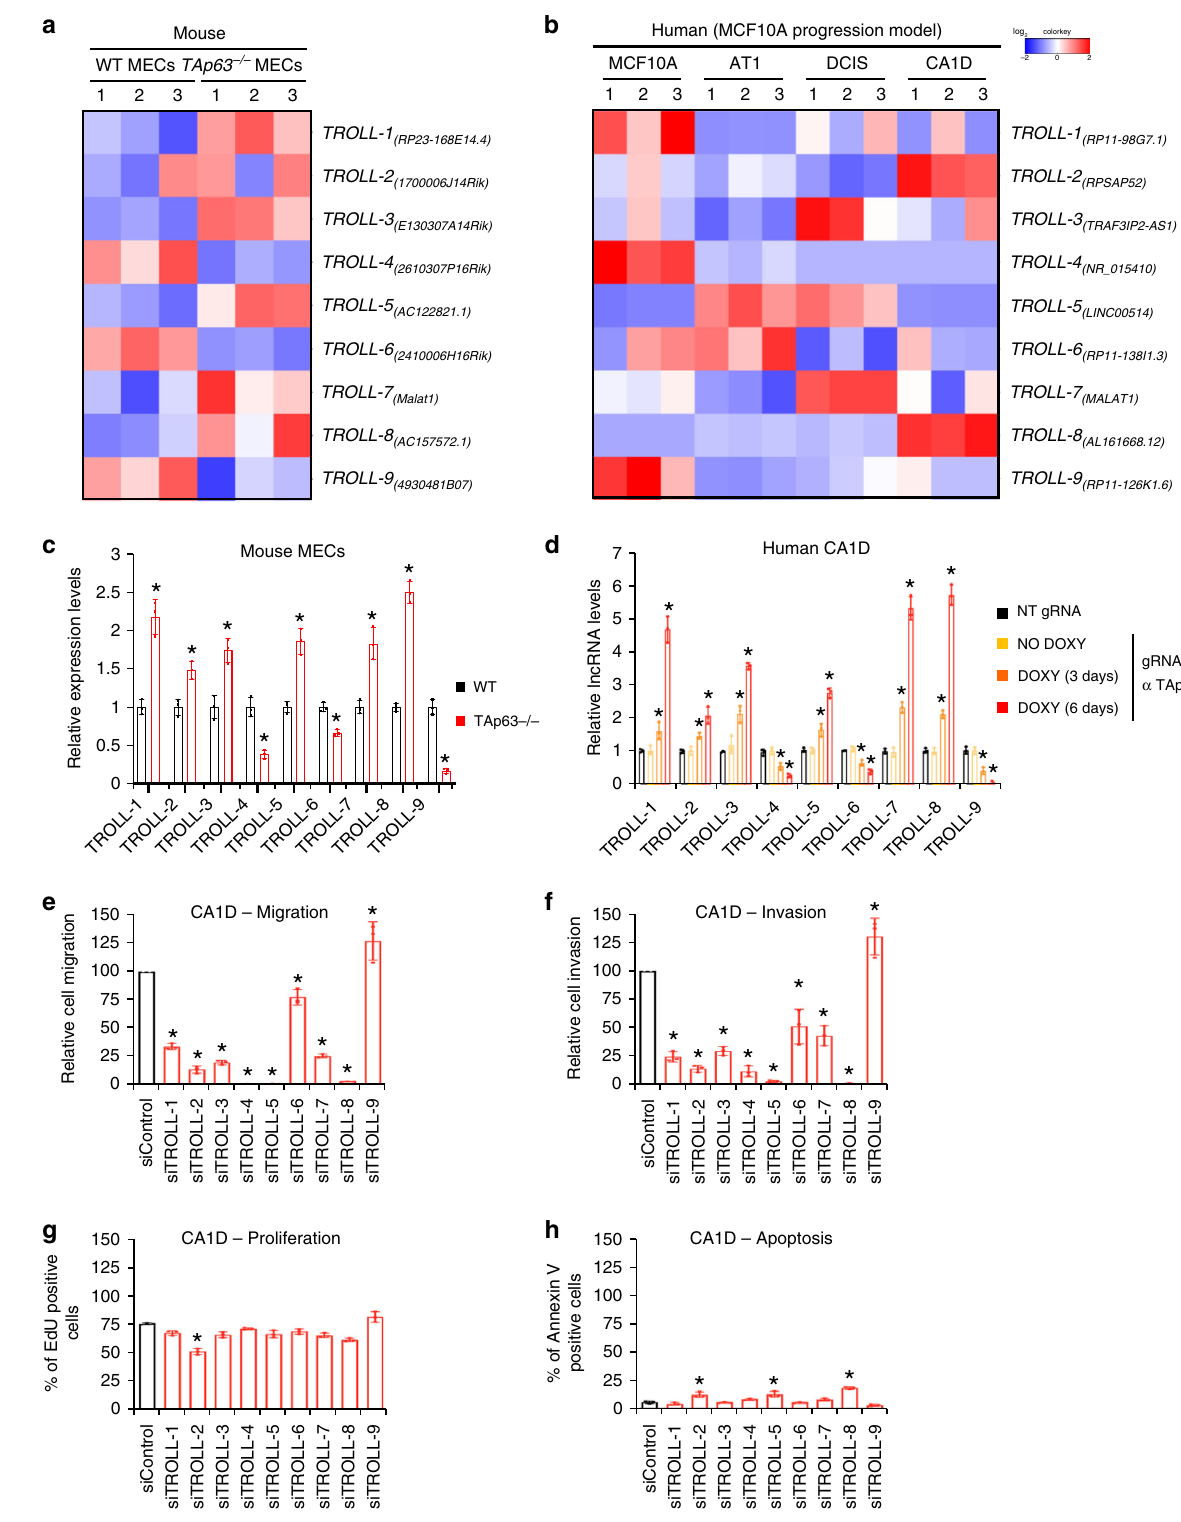
Fig. 1 TAp63 regulates lncRNAs in breast cancer progression. a Heatmap of the nine conserved lncRNAs differentially expressed in WT and TAp63 − / − mammary epithelial cells (MECs). b Heatmap of the nine conserved lncRNAs differentially expressed in the MCF10A human breast cancer progression model. c qRT-PCR of the nine conserved lncRNAs in WT and TAp63 − / − MECs. d qRT-PCR of the nine conserved lncRNAs in CA1D cells infected with either non targeting (NT) or TAp63 targeting gRNA. 3 days and 6 days indicate the time of Cas9 induction via doxycycline. e – h Quanti fi cation for cell migration ( e ), cell invasion ( f ), EdU incorporation ( g ), and annexin V positivity ( h ) of CA1D cells transfected with siRNAs against the indicated lncRNAs. Graphs represent the individual data points, mean ± SD of three independent experiments. P value (* p < 0.05) was calculated by two-tailed unpaired Student ’ s t -test. Source data are provided as Source data fi